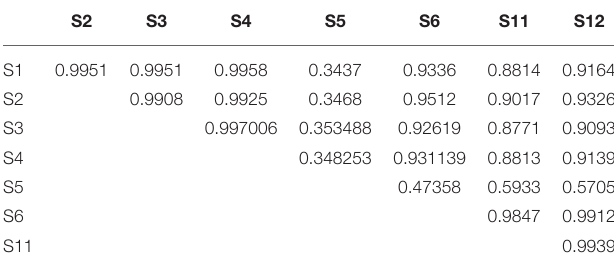
TABLE 1 | Correlation of sensors when the train is on adjacent span.